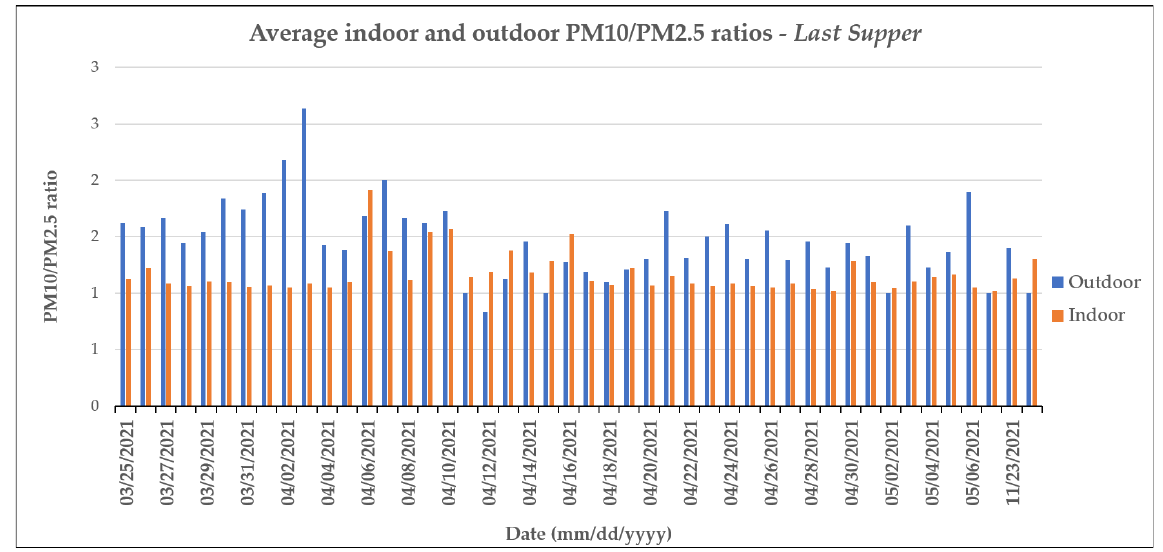
Figure 6. Average indoor and outdoor PM10/PM2.5 ratios for the sampling site at the Last Supper .